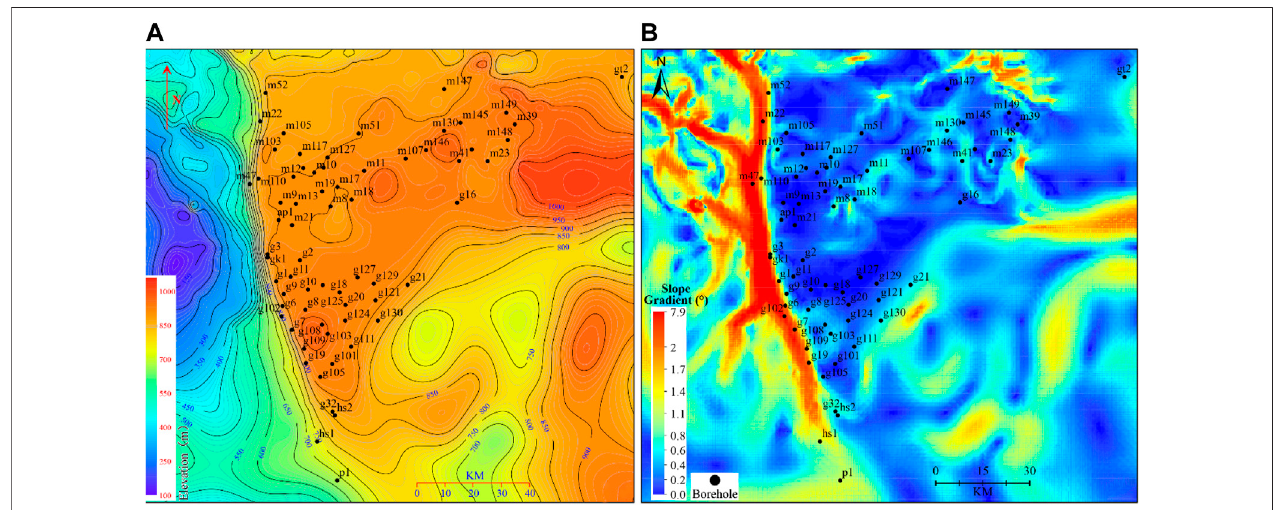
FIGURE 3 | (A) reconstructed paleogeomorphology on top of the Z 2 dn 4 in the GMA. (B) slope map corresponding to (A) based on DEM.